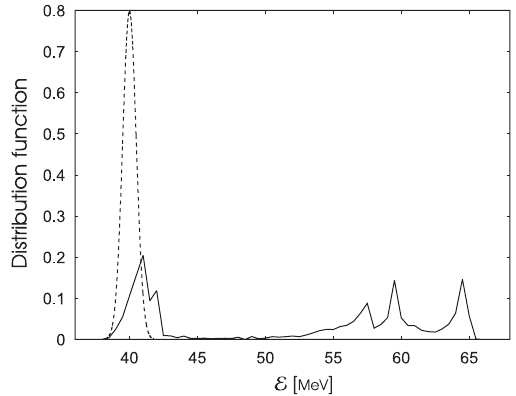
¼ 0 : 5 , for initial step l ¼ 0 u